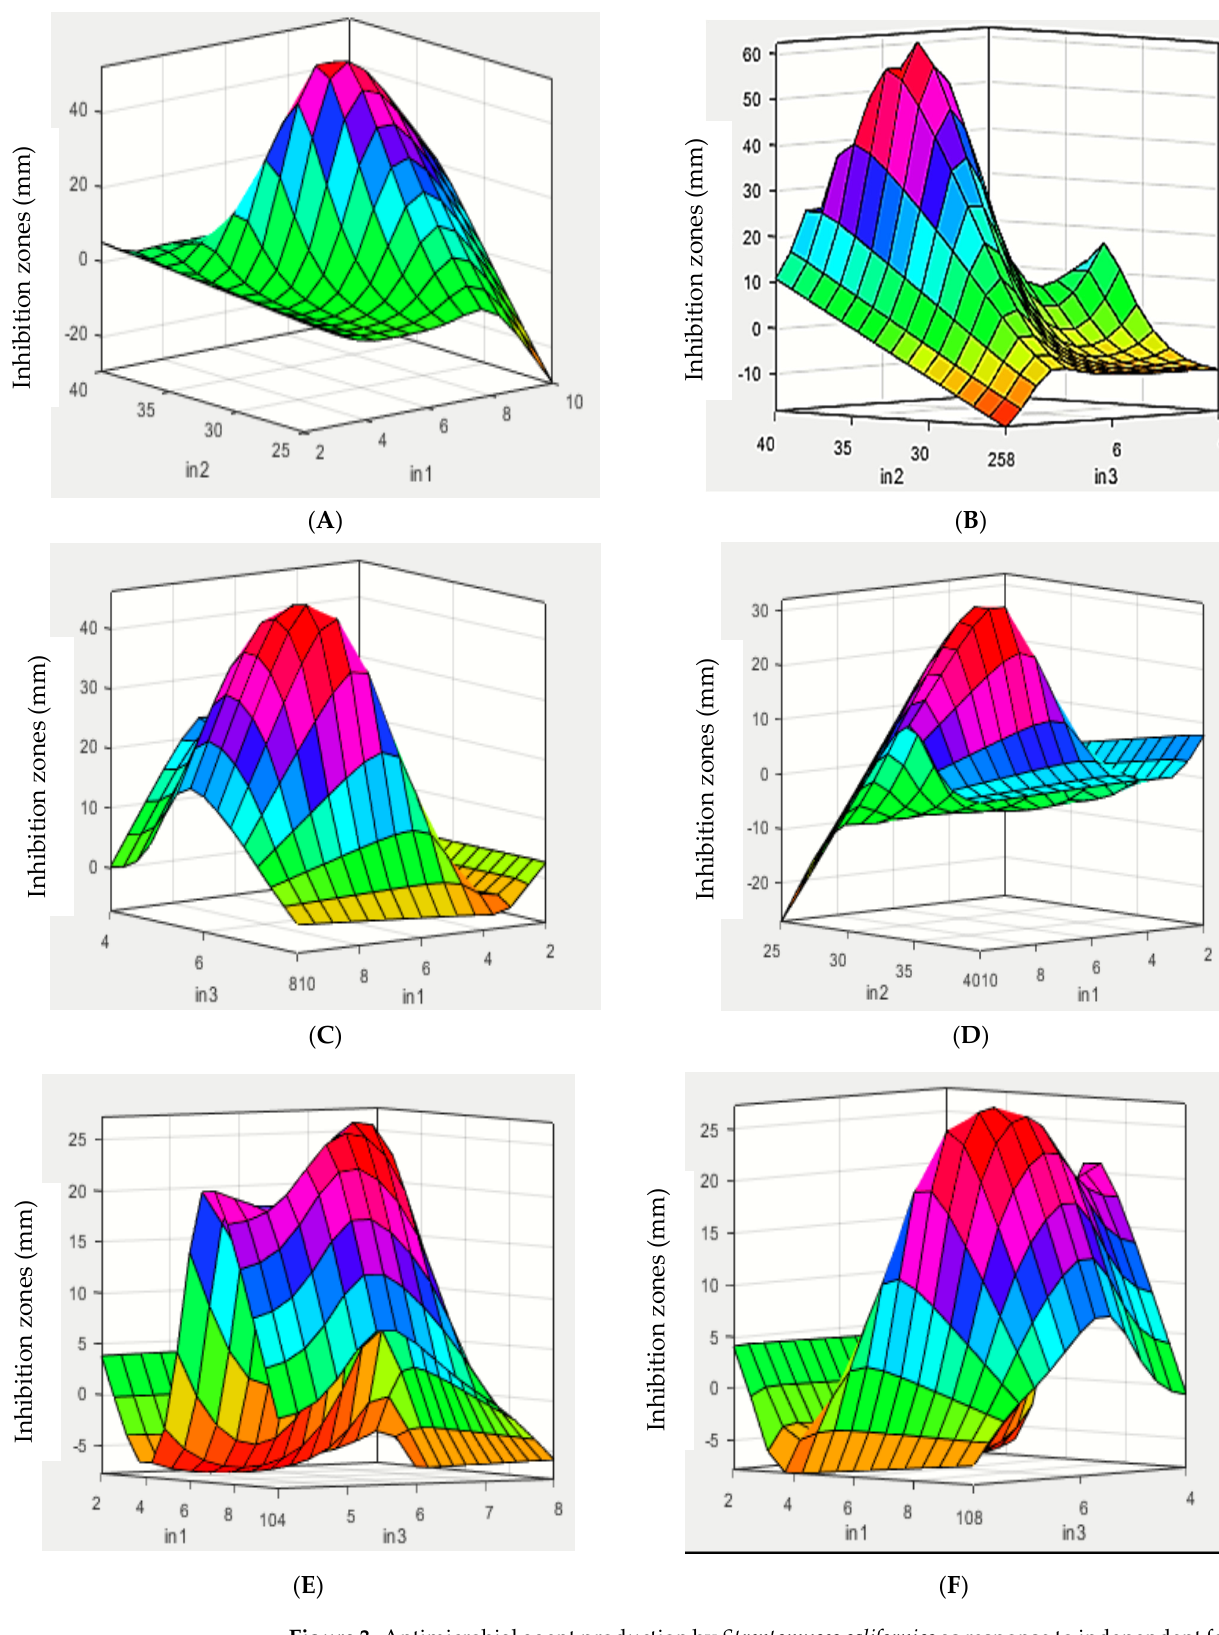
Figure 3. Antimicrobial agent production by Streptomyces californics as response to independent factors and predicted using ANFIS (time, day ( 𝐼𝑛1) , temperature (°C, 𝐼𝑛2 ), and pH ( 𝐼𝑛3) . ( A – C ) E. carotovora Erw 5 . ( D – F ) E. carotovora EMCC 1687. The optimization of antimicrobial production by S. californics (22/30a) was performed using ANFIS with three independent factors, including temperature (25–40 °C), pH (4–8), and time (2–10 days) (Figures 4 and S1). The results revealed that the production of anti- bacterial agents increased with the increasing incubation period, with diameter of inhibi- tion zones of 11 and 13 mm against E. carotovora Ewr 5 and E. carotovora EMCC 1687, re- spectively. The highest production of antibacterial agents was observed at 28 °C, with the highest inhibition zones being 13 and 15 mm against both E. carotovora Ewr 5 and E. caroto- vora EMCC 1687, respectively. At 30 °C, the inhibition zones were 11 and 13 mm against both of E. carotovora Ewr 5 and E. carotovora EMCC 1687, respectively, whereas no antibac- terial activity was observed at the 25, 37, or 40 °C incubation temperatures. The effect of different initial pH values of the fermentation medium showed that the antibacterial ac- tivity increased with the decrease in pH, with the highest inhibition zones being 15 and 17 mm against both E. carotovora Ewr 5 and E. carotovora EMCC 1687, respectively.